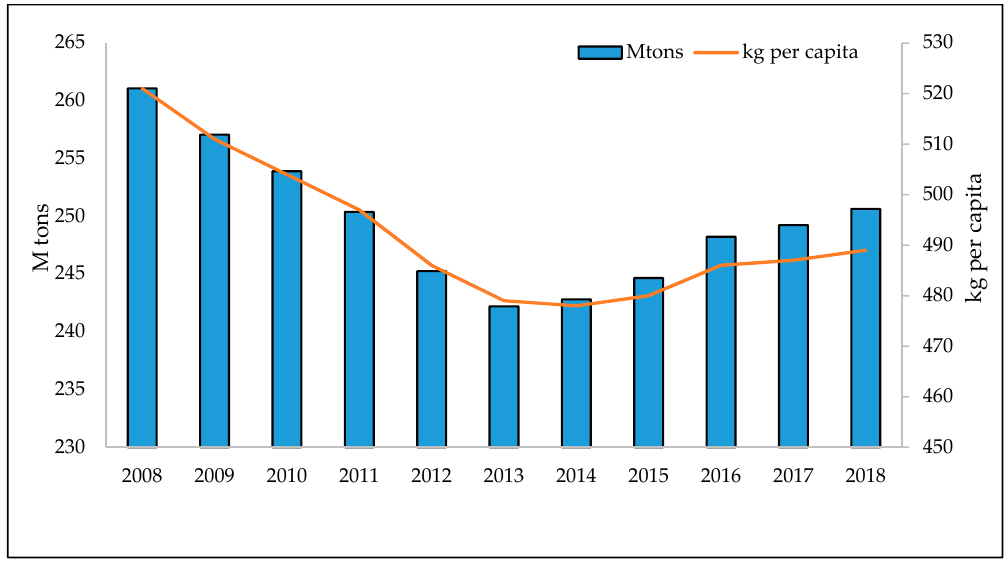
Figure 1. Municipal Solid Waste (MSW) produced in EU-28 in 2008–2018, in million tons and kg per capita [1].